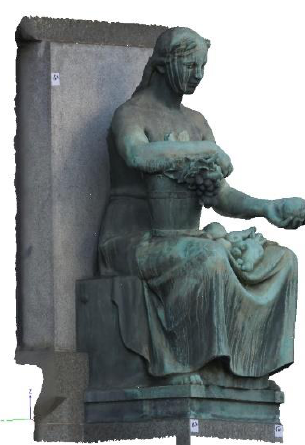
Figure 7. 3D model in MISYS SPRÁVA